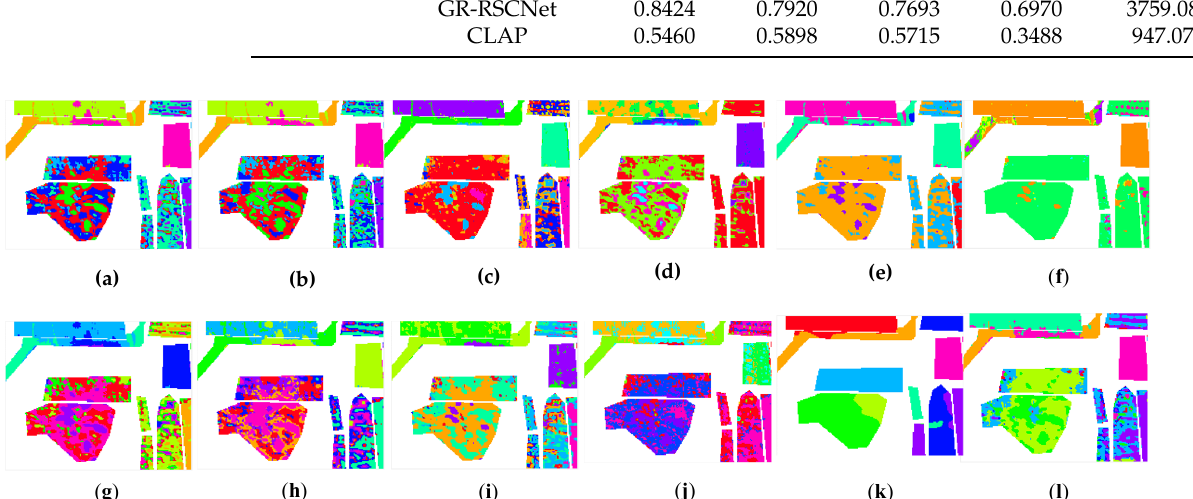
Figure 6. The unsupervised clustering maps of the Pavia University dataset. ( a ) K ‐ means. ( b ) K ‐ methods. ( c ) GMM. ( d ) DBSCAN. ( e ) SC. ( f ) DPC. ( g ) Self ‐ org. ( h ) CL. ( i ) AP. ( j ) HESSC. ( k ) GR ‐